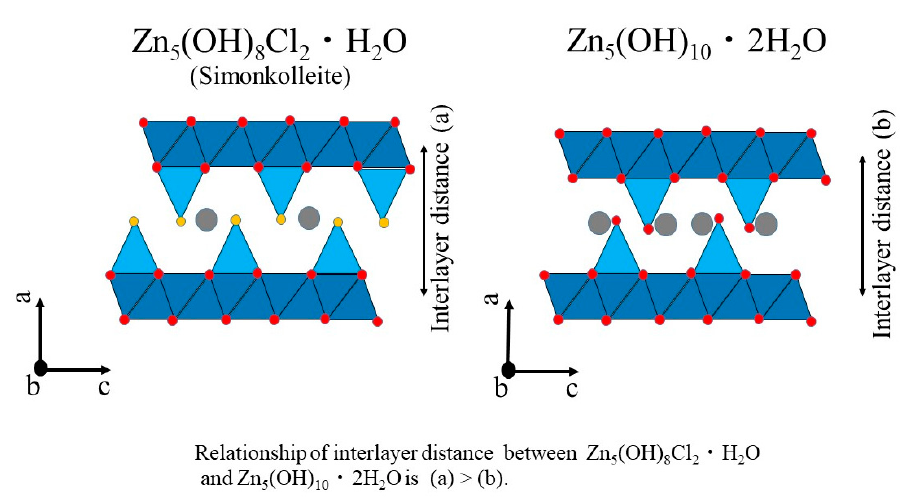
Figure 11. Crystal structures of rhombohedral simonkolleite and monoclinic Zn 5 (OH) 10 · 2H 2 O. Stacking layers viewed along the b-direction. The top row shows the layer of edge-sharing octahedra (dark blue) with different arrangements of vacant sites where two tetrahedrally coordinated Zn 2+ ions (light blue) are situated above and below. Intercalating H 2 O is drawn as gray spheres. Red and yellow spheres represent OH − and Cl − , respectively.